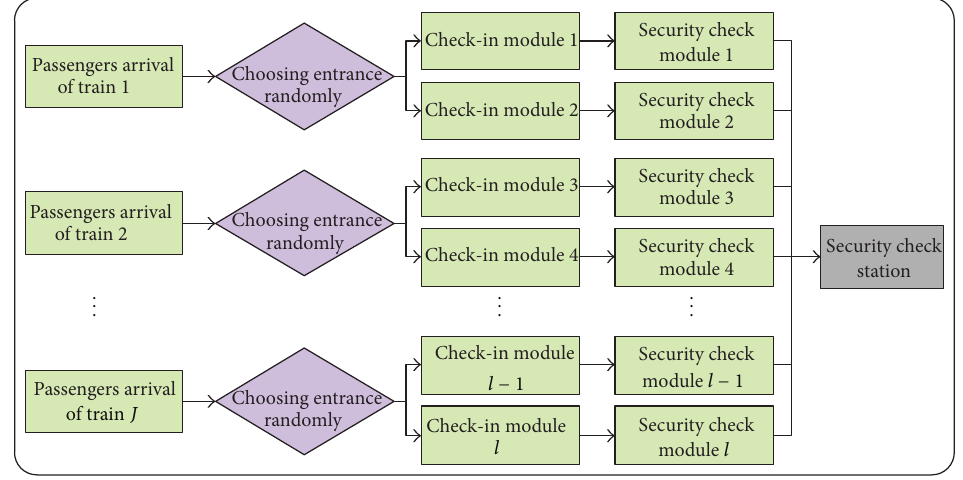
Figure 5: Arrival, check-in, and security check module.